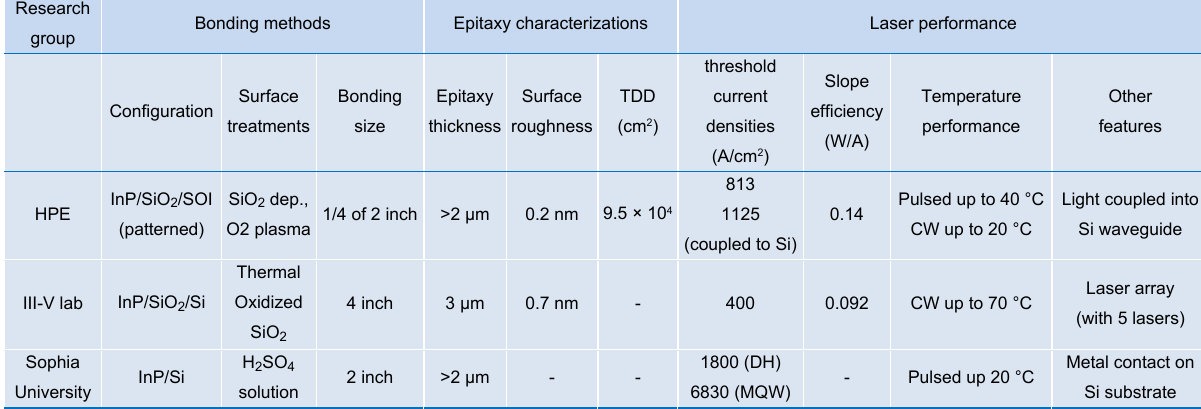
Table 1 | A comparison of the main features in the demonstrations from the three research groups.